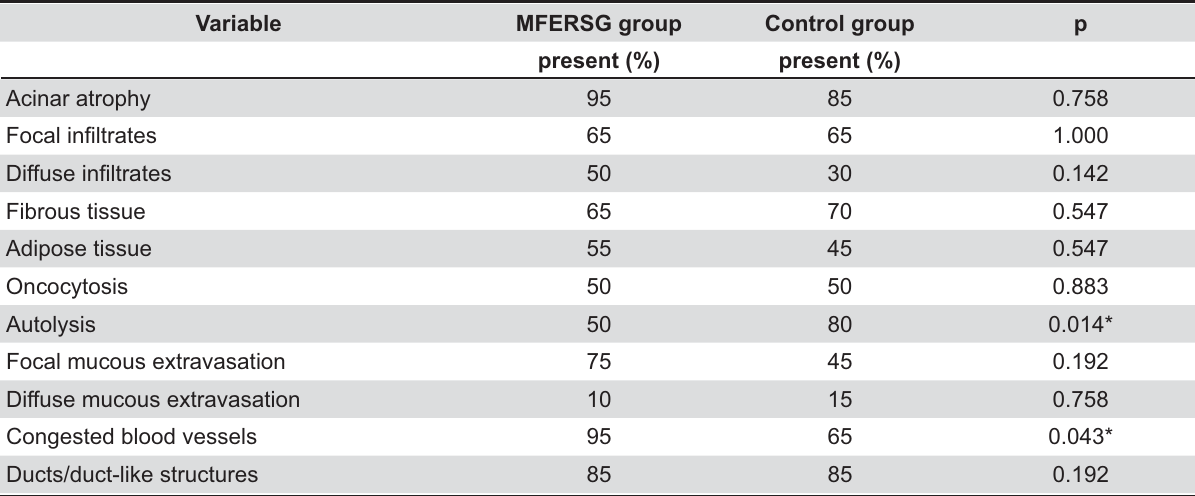
Table 1- Group comparisons derived from the morphologic